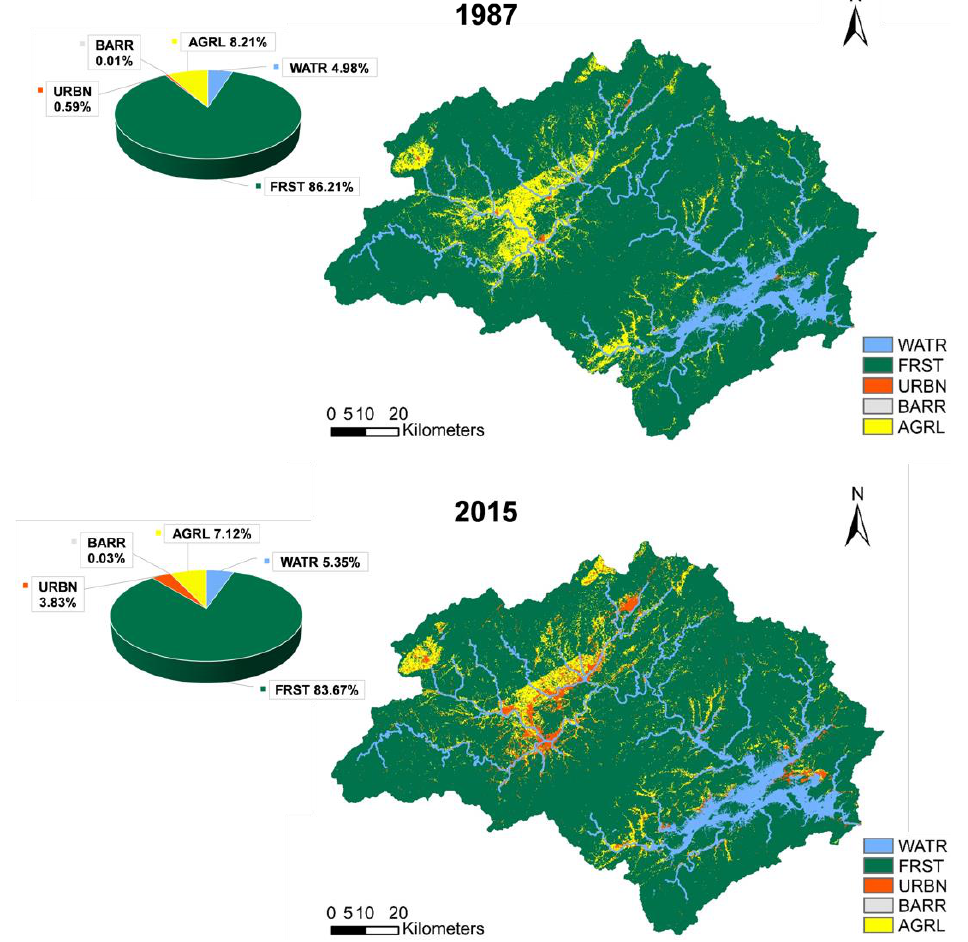
Figure 4. The land use/land cover classification maps in 1987 and 2015 under the SN and SN LC scenarios and the proportion of area of each land use/land cover type. The land use/land cover in 1987 and 2015 represent the land use/land cover in the simulation baseline period (1973 – 2005) and the future (2068 – 2100), respectively. WATR indicates water body, FRST indicates forest, URBN indicates urban land, BARR indicates bare land, AGRL indicates cultivated land.